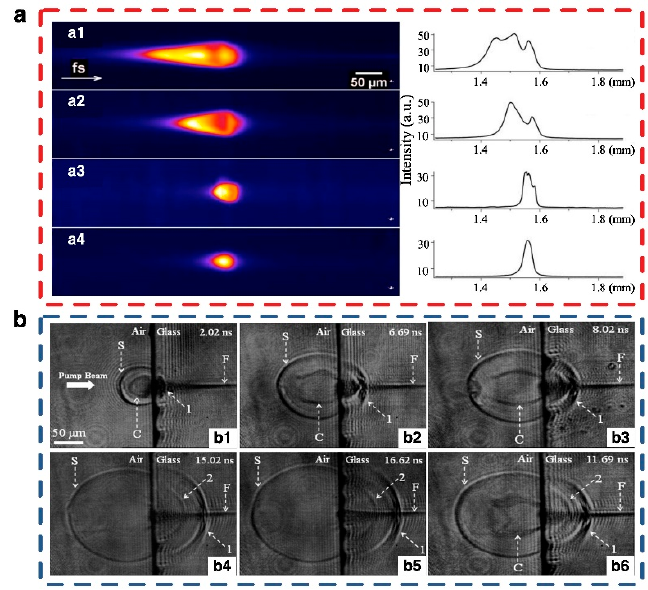
Figure 16. The shockwave and plasma emission images of dielectric. ( a ) Plasma emission and the corresponding intensity cross sections along the z-axis. a1 , a2 , and a3 obtained for pulses of energies of 9.6 μ J and pulse durations of 100 fs, 250 fs, and 550 fs, respectively. In a4 , the pulse duration is 250 fs and the pulse energy is 4 μ J; ( b ) The shadowgraphs of femtosecond laser ablation of dielectric recorded at six different delay times by TRPP, where S: shockwave front; C: contact front; 1: the first stress wave front; 2: the second stress wave front; and F: filament. The energy fluence on the target surface is 40 J/cm2, and laser pulse is 50 fs [85,86].